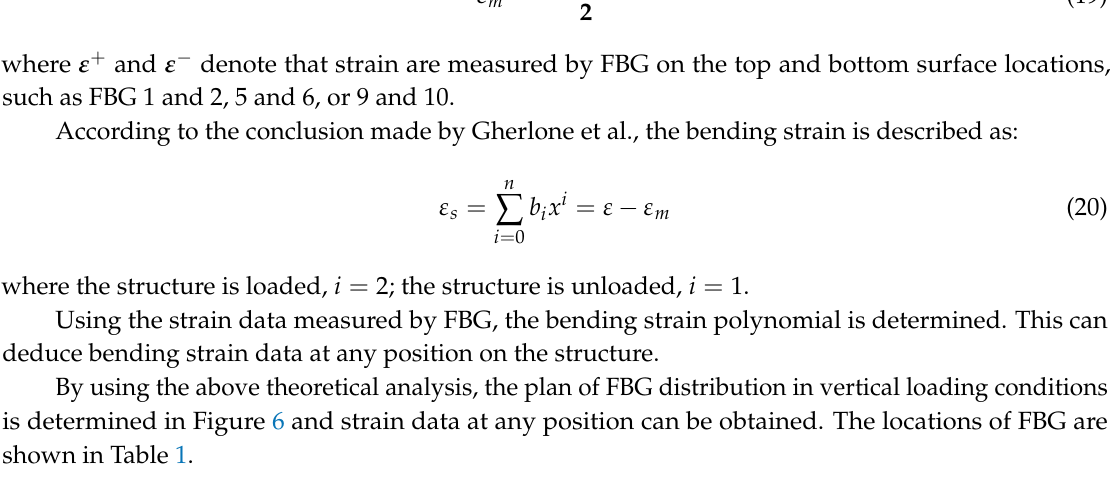
Table 1. The locations of FBG (Unit: mm).